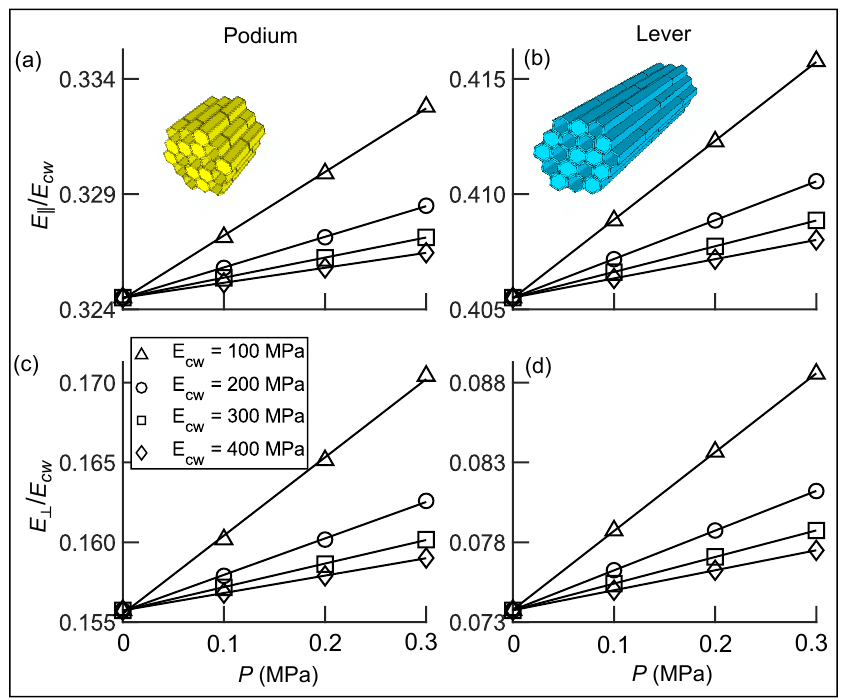
Figure 7. ( a,b ) Ratio of longitudinal elastic moduli E ∥ / E cw of the podium and the lever respectively. ( c,d ) Ratio of the transverse elastic moduli E (cid:150) / E cw of the podium and the lever respectively, calcu- lated for different turgor pressures P and cell wall elastic moduli E cw ( △ = 100MPa, ◯ = 200MPa, ◻ = 300MPa and ◇ =